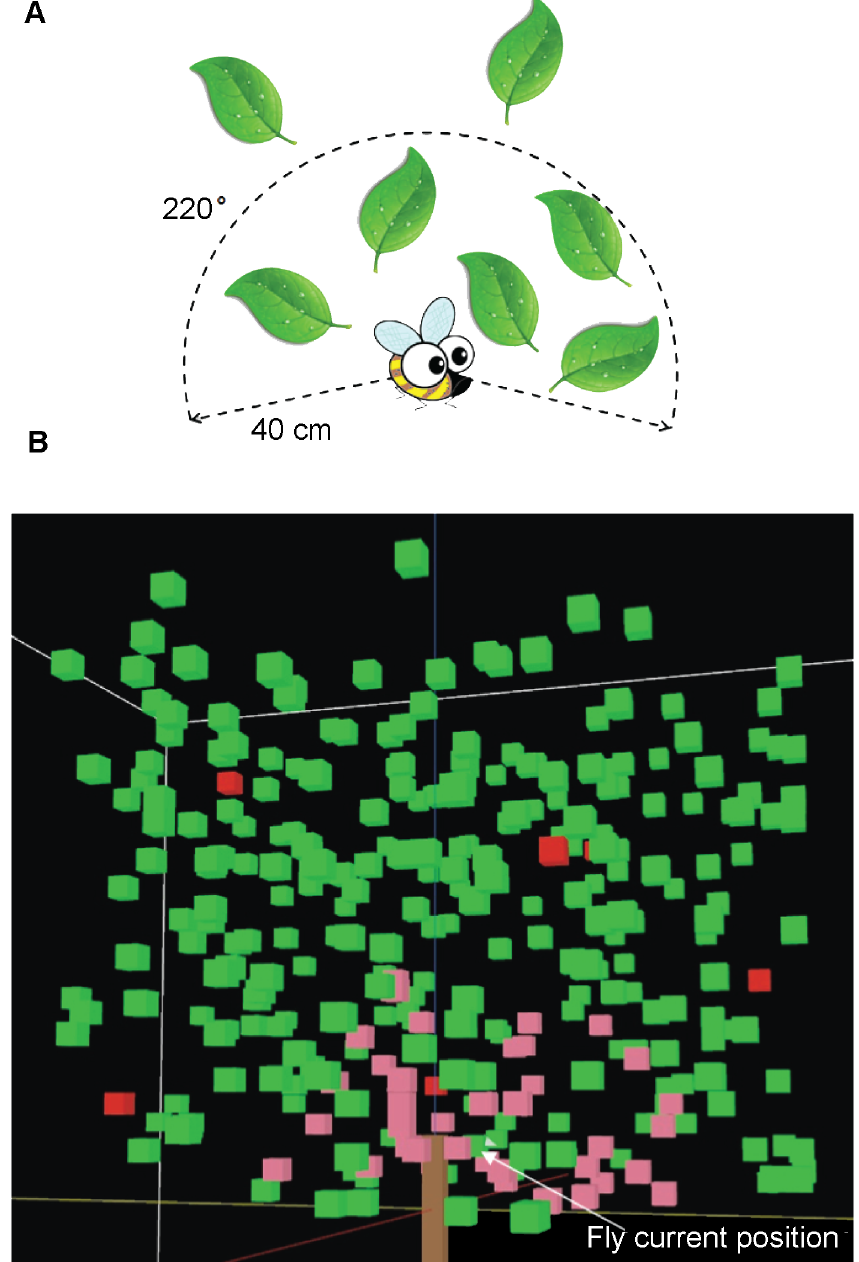
Fig 4. Examples of the sensing volume of an individual fly. A: the 2D representation of sensing volume for an individual fruit fly with 40 cm detection radius and 220° sensing angle. B: an example of the sensing volume of an individual fly in the 3D model. The pink cubes are located within the sensing volume in the closed-canopy with 40 cm and 220 degrees as detection radius and sensing angle respectively. Green cubes represent leaves outside of the sensing volume and red cubes simulate host